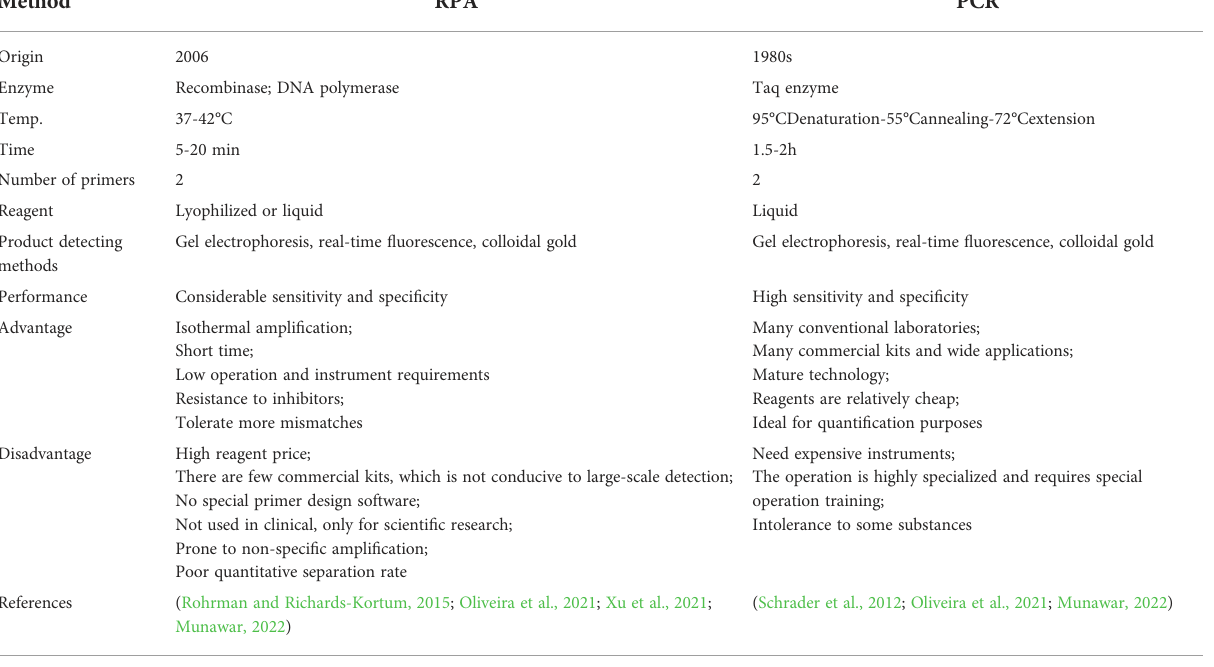
TABLE 1 Comparison of RPA and